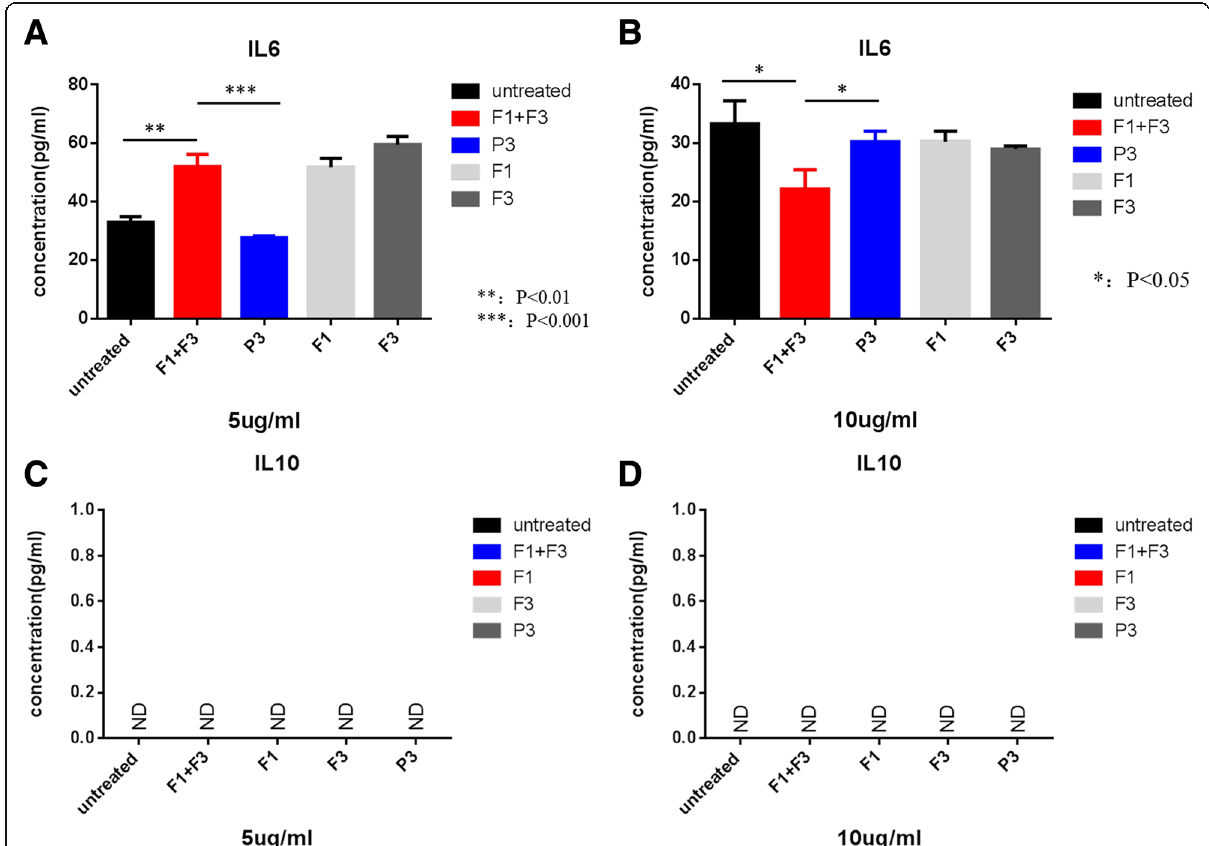
Fig. 5 Caerin peptides induce TC-1 cells to secrete more IL-6 5 or 10 μ g of Caerin 1.1 (F1) and Caerin 1.9 (F3) peptides or control peptide P3 were added to 8×10 3 TC-1 cells in flat bottomed 96 well plates and cultured overnight at 37°C with 5% CO 2 . IL-6 and IL-10 from the supernatants of caerin peptide treated TC-1 cells were detected by ELISA. IL-6 ( a , b ). IL-10 ( c , d